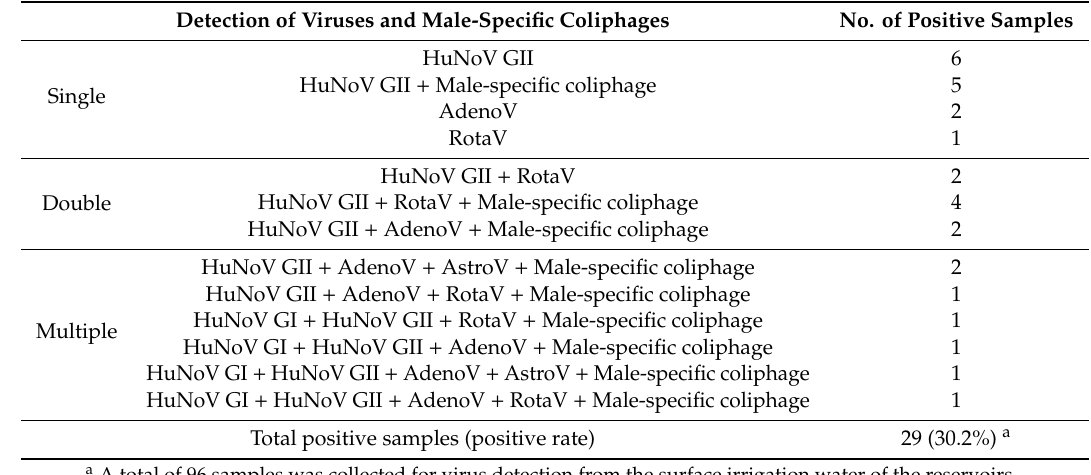
Table 4. Profiles of viruses and male-specific coliphages detected in the reservoirs. Detection of Viruses and Male-Specific